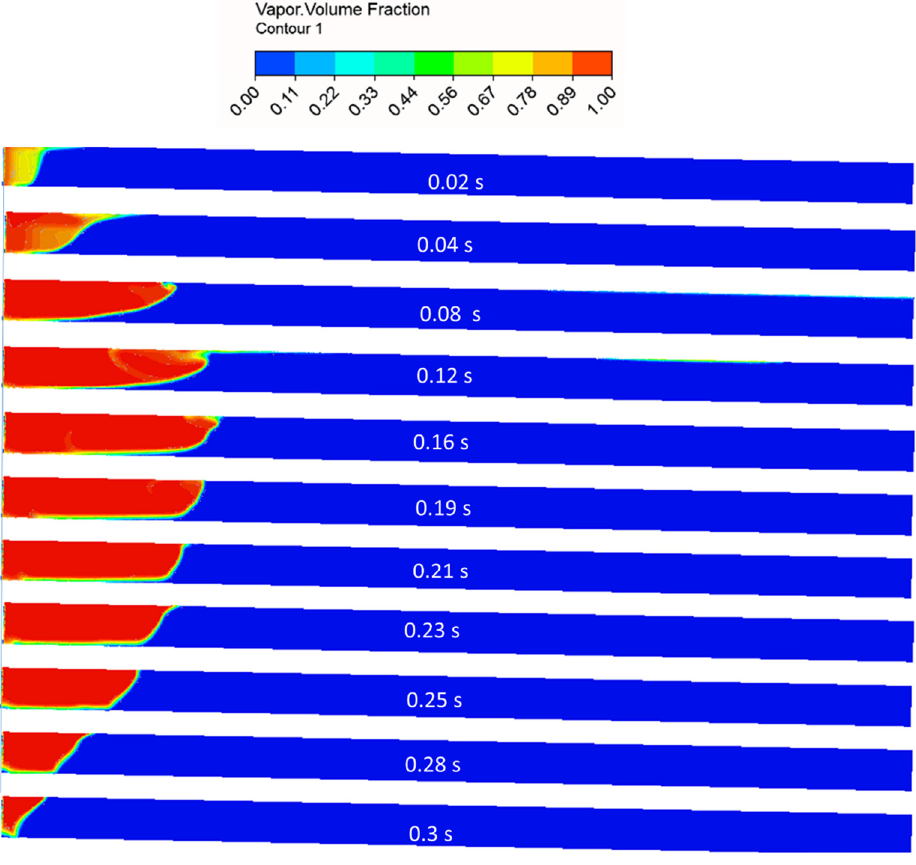
Figure 9. cavity size evolution captured by 1D-3D. Figure 9. Cavity size evolution captured by